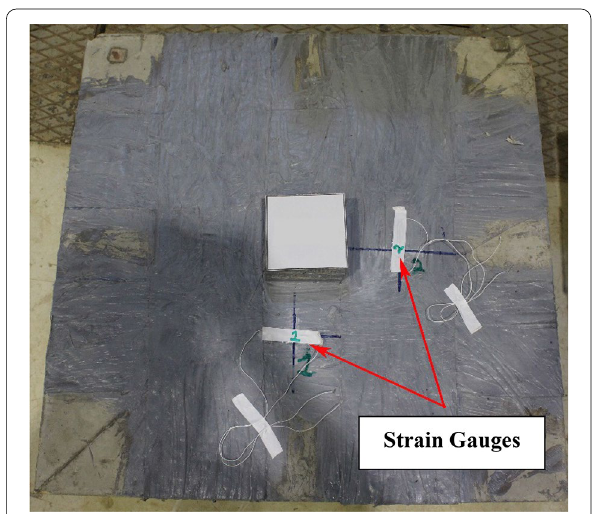
Fig. 3 View of a specimen after bonding the strengthening sheets and after installing the two strain